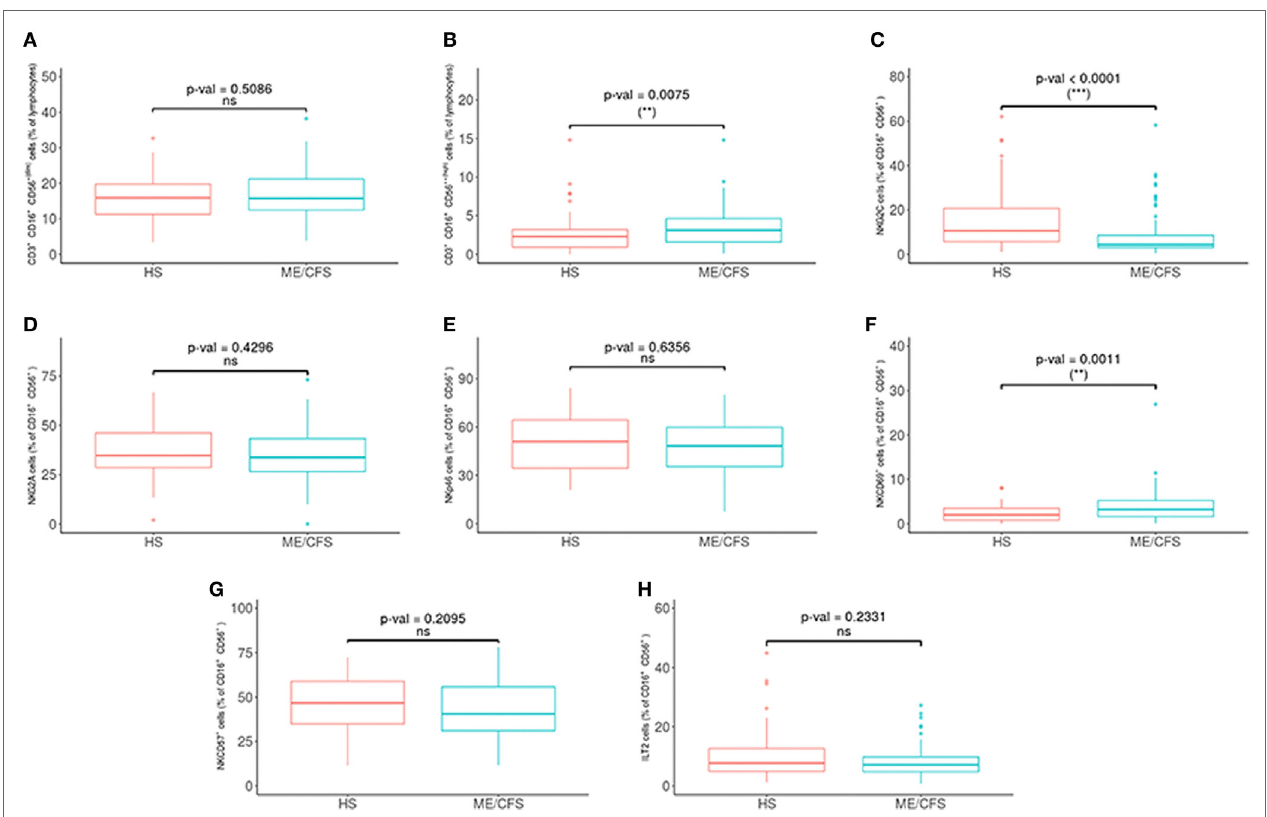
FigUre 3 | Analysis of NK cell subsets in myalgic encephalomyelitis/chronic fatigue syndrome (ME/CFS) patients ( n = 76) and healthy subjects ( n = 73). (a,b) NK cells as CD16 + / − CD56 + (dim) and CD16 + / − CD56 ++ (high) were obtained in gated CD45 + lymphocytes. (c–h) Percentages of NKG2C, NKG2A, NKp46, NKCD69, NKCD57, and ILT2 NK cells were obtained after gating for CD16 + / − CD56 + lymphocytes. Figures show median values (lines), interquartile ranges (boxes), and 10–90 percentile values (bars). p Values obtained by Wilcoxon non-parametric